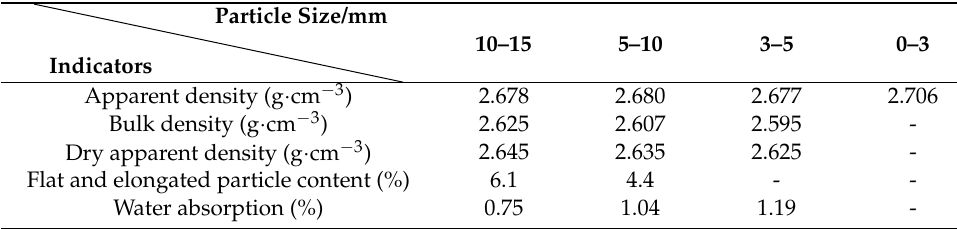
Table 4. Basic properties of aggregates.